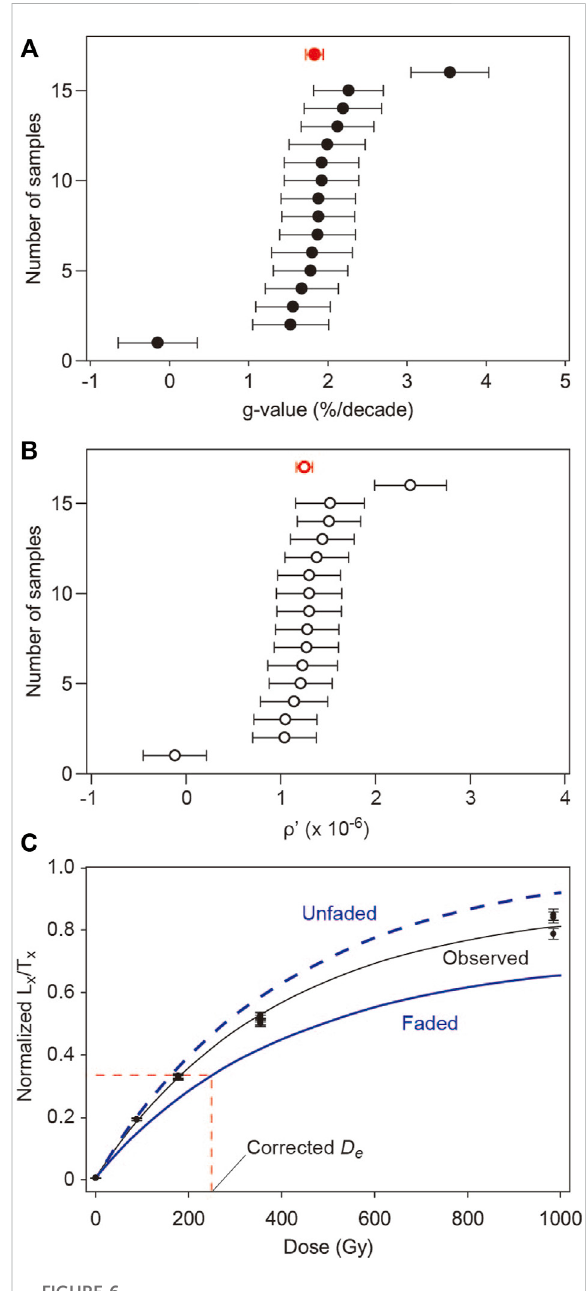
FIGURE 6 (A) Cumulative distribution oftheg 2days -valuedeterminedfor anindividualsample.Aredpointshowstheaveragevalueforallthe samples. (B) Cumulative distribution of the ρ ′ , dimensionless density of recombination centers. A red point shows the average value for all samples. (C) An example of fading correction with measured, unfaded, and faded dose-response curves for the pIRIR 225 signal from sample